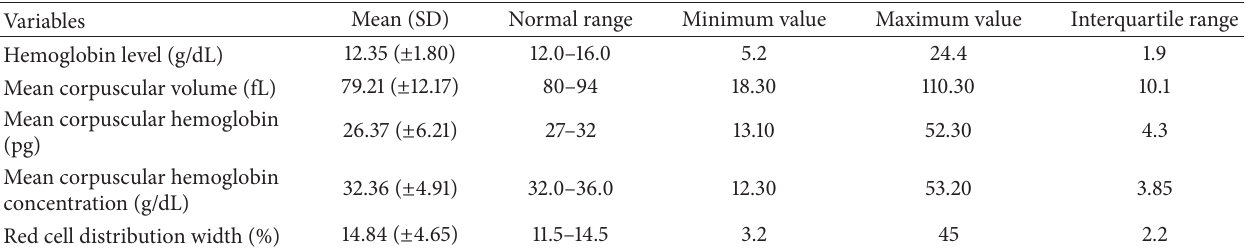
Table 1: Mean blood hemoglobin and red blood cell parameters in child bearing age women in Riyadh, Saudi Arabia ( 𝑛 = 969